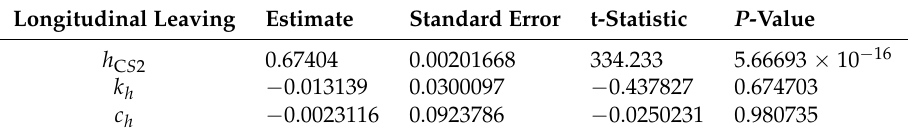
Table 8. The parameters of fitting h S 2 = h C S 2 + k h homogeneity leaving the